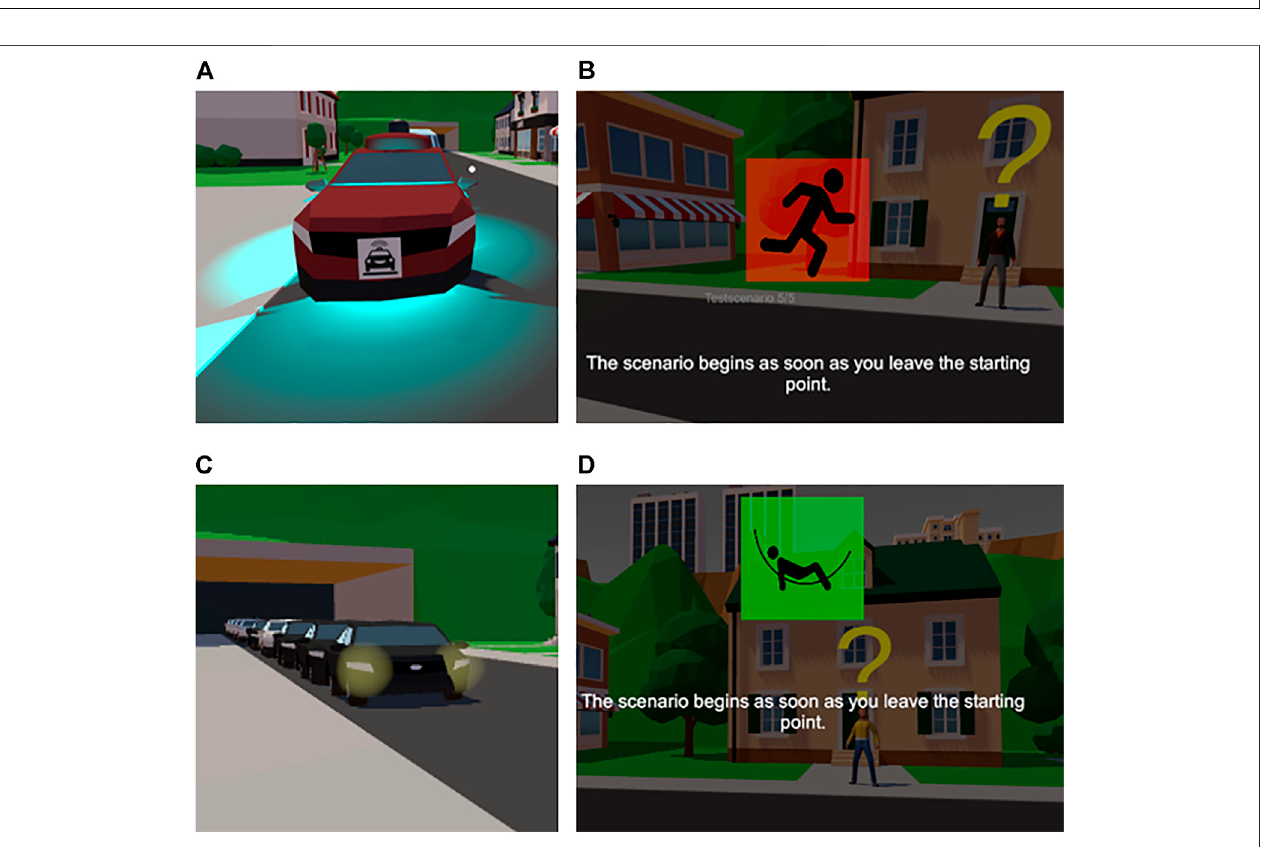
FIGURE3| Vehicletypeandtaskurgencyfactor levelsintheexperiment. (A) DeceleratingAVcastsbluelightcues. (B) Urgenttaskindicatorwitharunningmanon a red background. (C) Decelerating HDV fl ashes headlights. (D) Non-urgent task indicator with a resting man on a green background.